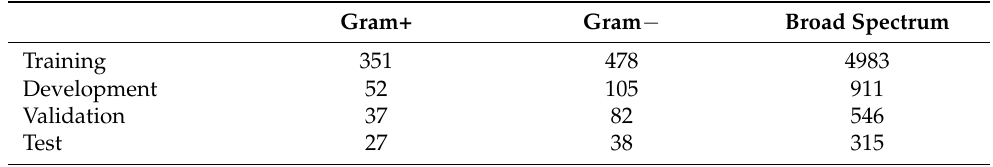
Table 1. Number of peptides per type of Gram staining class in the training, development, validation, and test datasets.